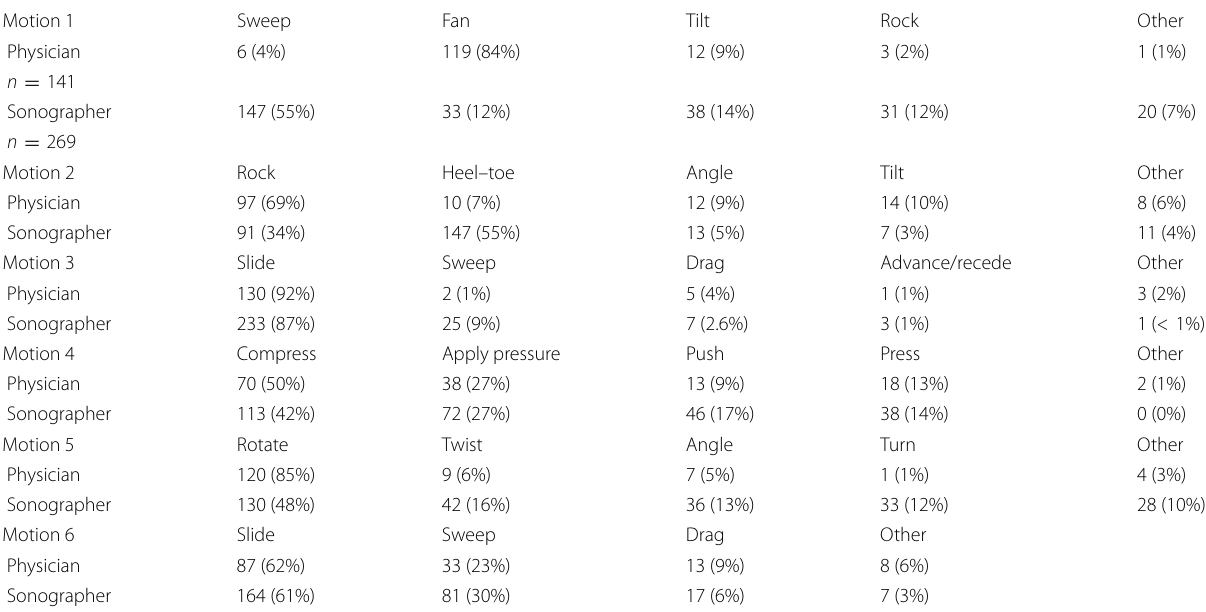
Table 3 Comparison of sonographer and physician responses Motion